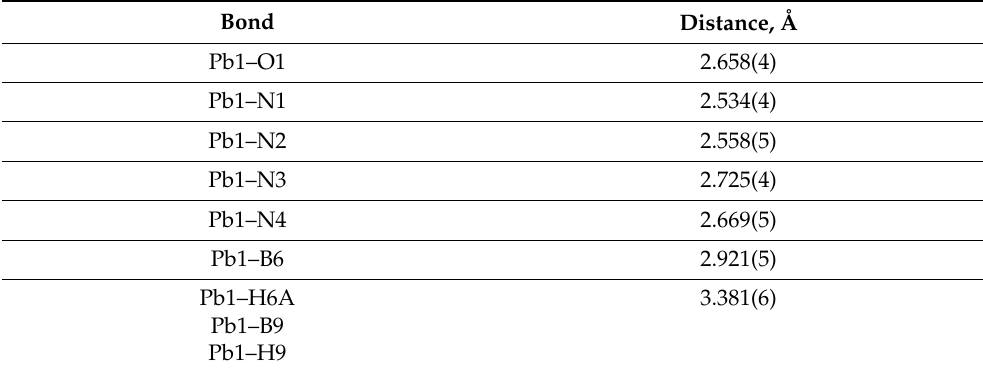
Table 2. Metal–heteroatom distances in complex 2 · 0.5bipy · CH 3 CN. Bond Bond Distance,